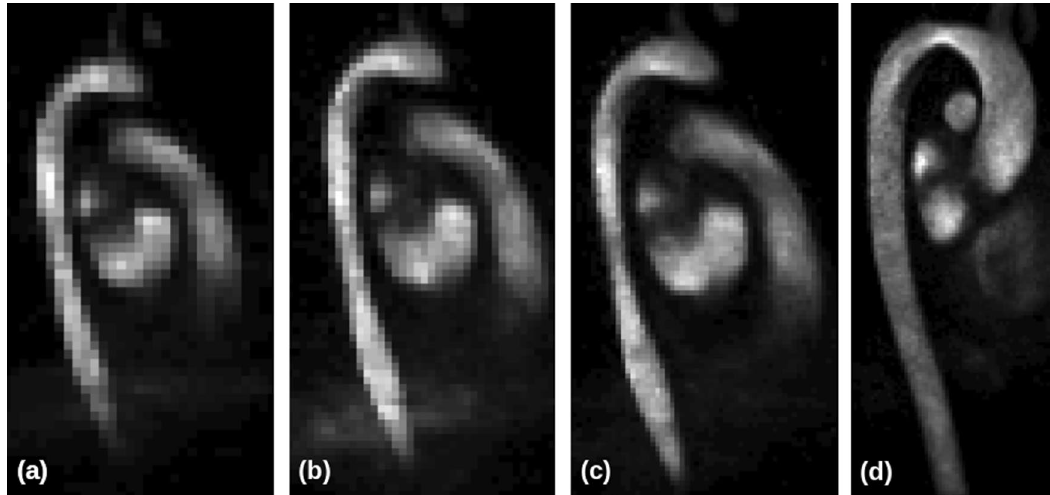
Figure 1. 4D-flow MRI images of the thoracic aorta at the same location in the sagittal plane, taken at four 3 varying spatial resolutions ( x × y × z mm ). ( a ) 4 mm × 4 mm × 4 mm , ( b ) 3mm × 3 mm × 3mm , ( c